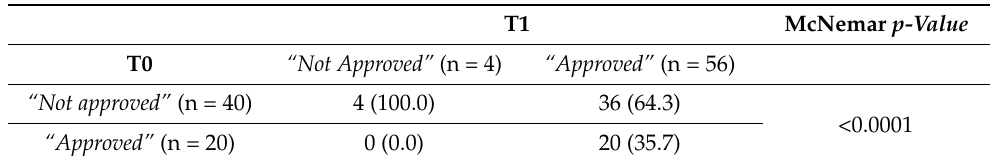
Table 2. Paired distribution between categorical disinfection data at T0 and T1 for all tested surfaces; ( p <